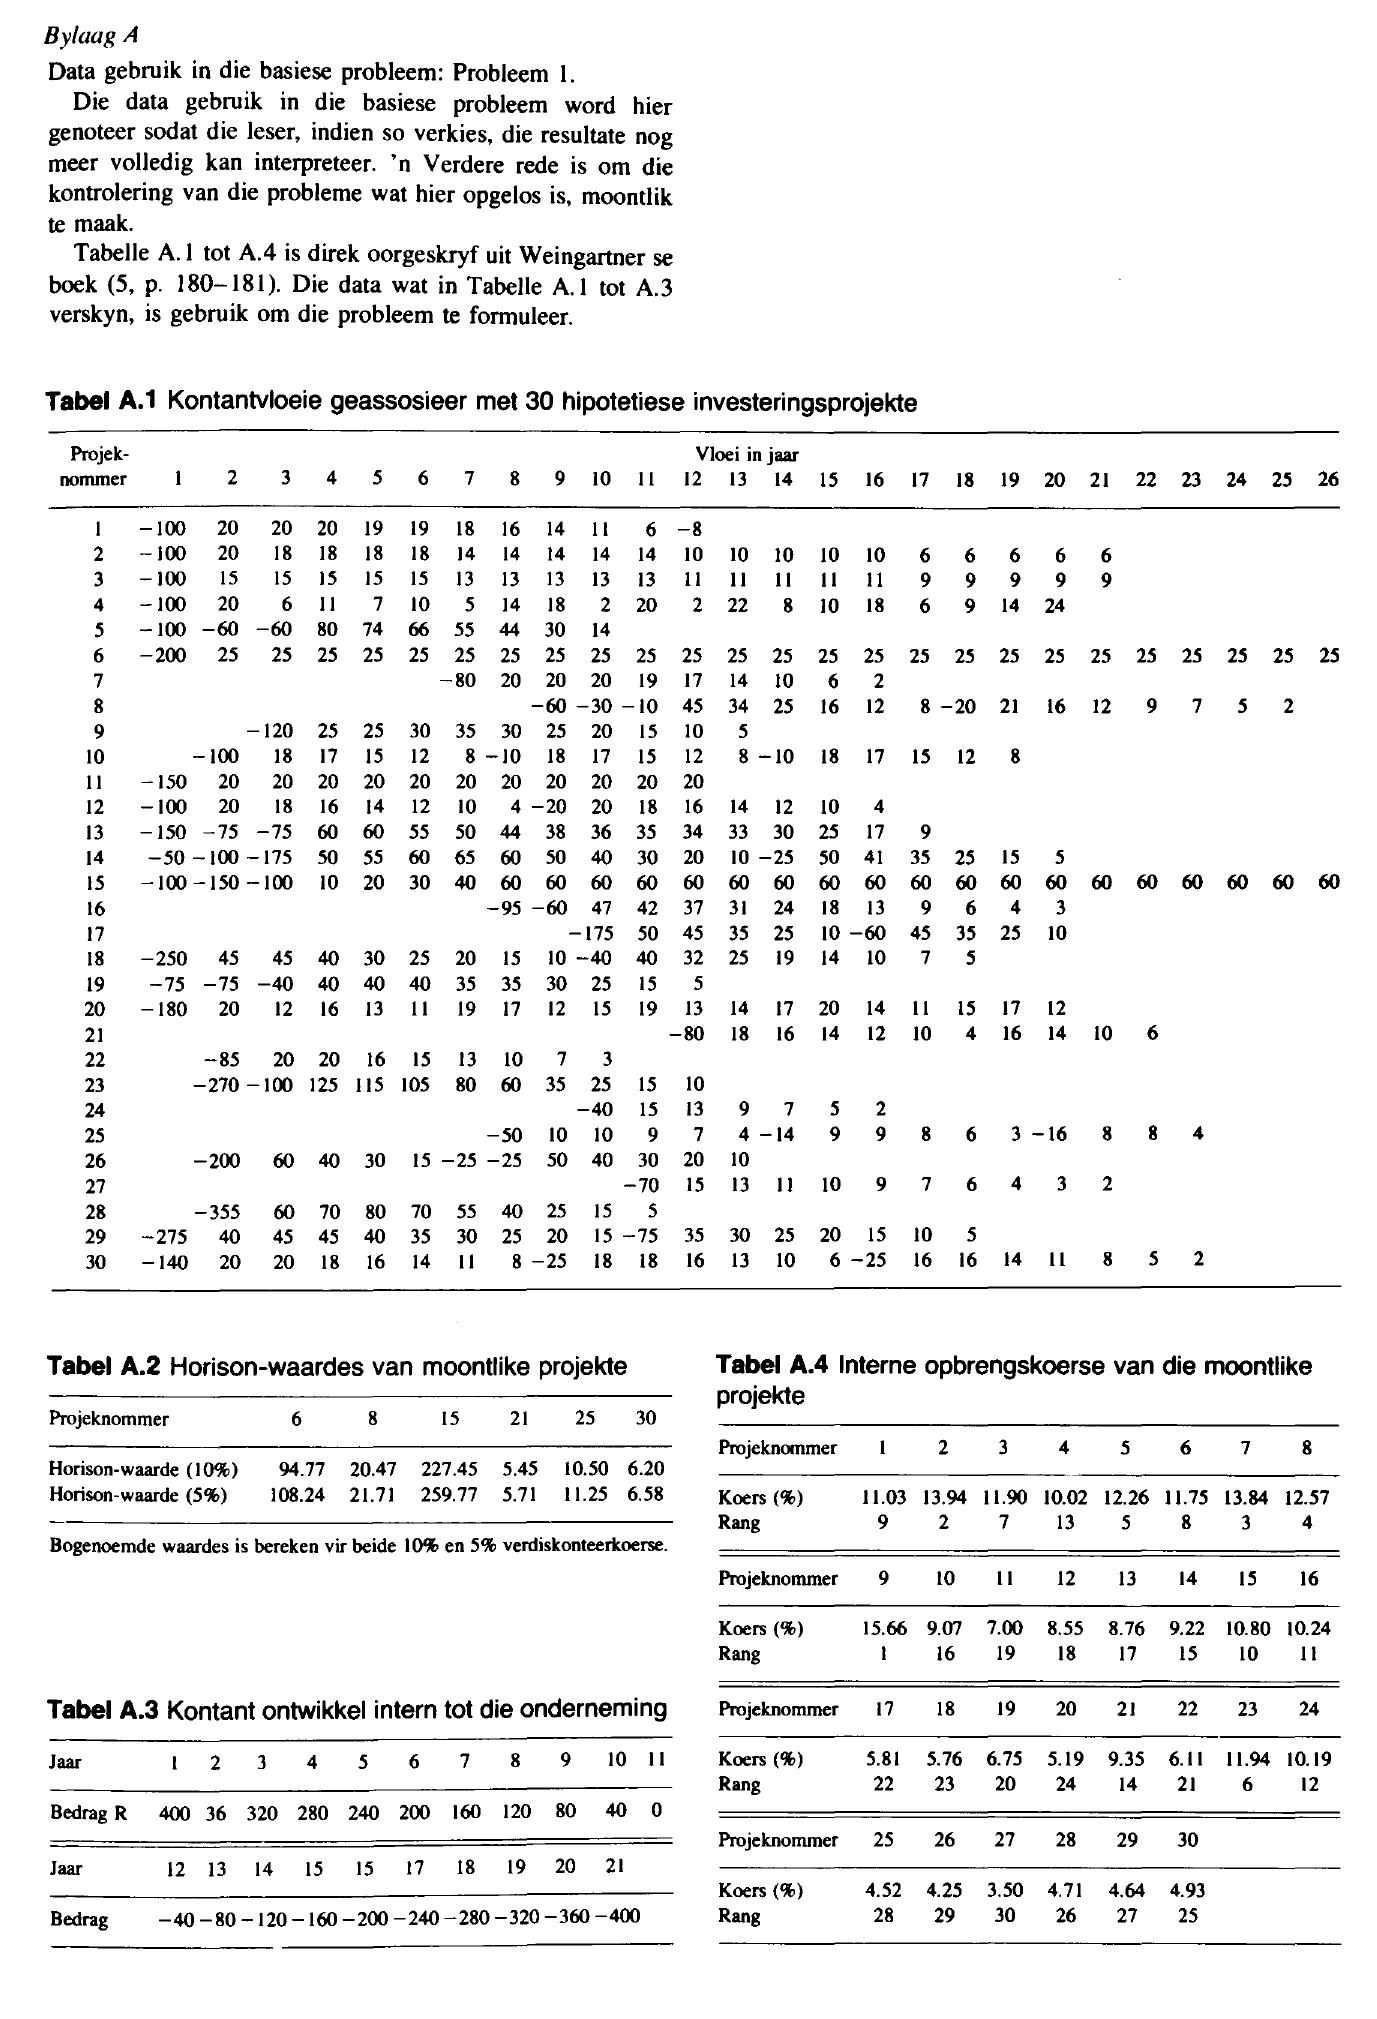
Tabel A.3 Kontant ontwikkel intern tot die onderneming